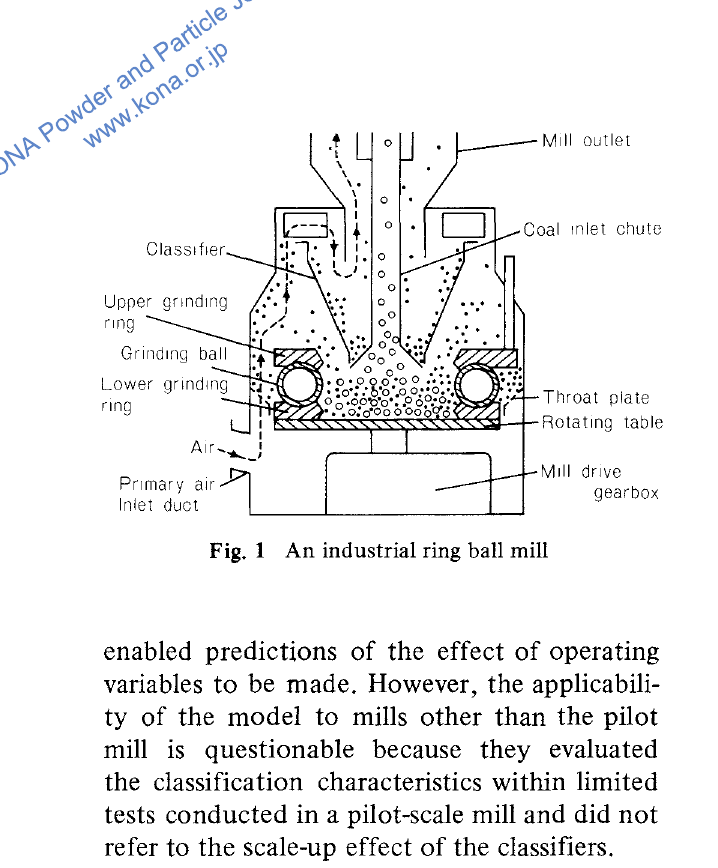
Fig. 1 An industrial ring ball mill